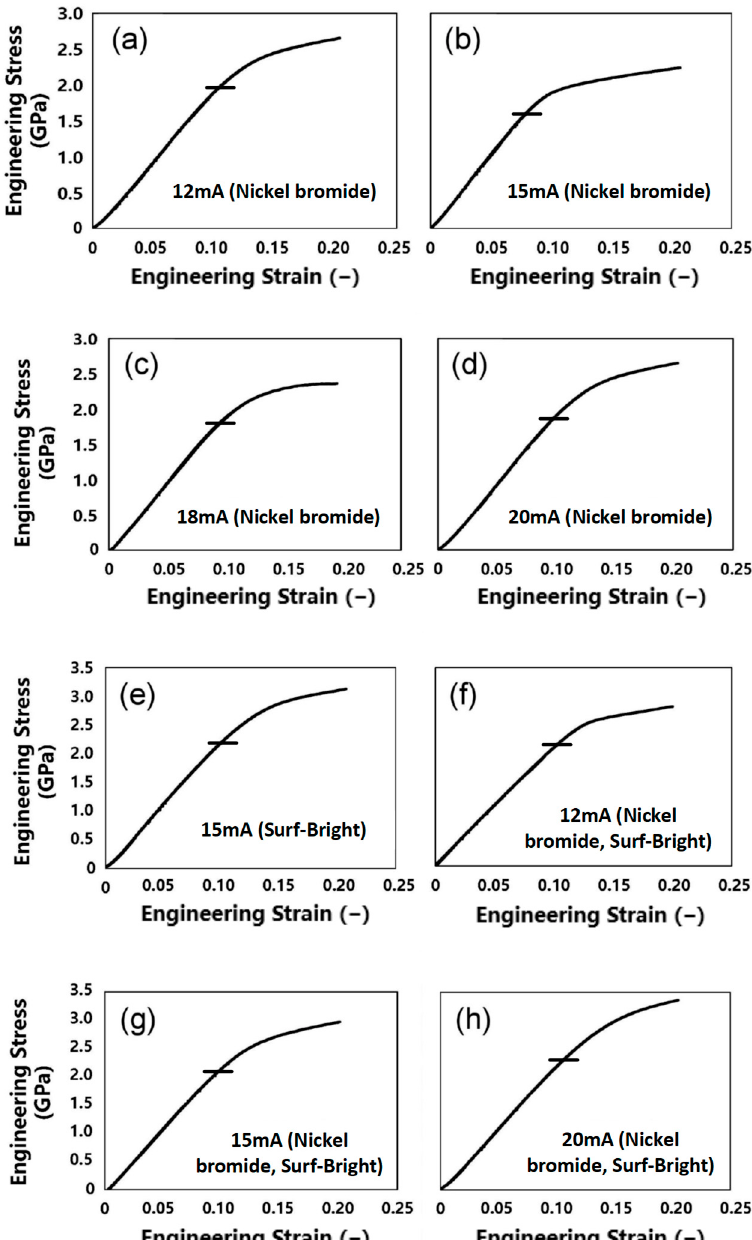
Figure 6. Engineering stress–strain curves generated from compression of the micro-pillars fabri- cated from the nickel–cobalt alloys electrodeposited with the bath containing ( a – d ) nickel bromide, ( e ) the Surf-Bright, or ( f – h ) both nickel bromide and the Surf-Bright, and at a current density of ( a , f ) 12 mA/cm 2 , ( b , e , g ) 15 mA/cm 2 , ( c ) 18 mA/cm 2 and ( d , h ) 20 mA/cm 2 . Relationships between the average grain size, micro-hardness and yield strength are shown in Figure 7. Generally, for both of the micro-hardness and yield strength, strengthening was observed following a refinement of the average grain size as illustrated by the dashed trendlines. This trend followed the Hall-Petch relationship well [29,30], and confirmed that the mechanical strength was mostly dependent on the grain boundary strengthening mechanism. Alloys with smaller grain size have fewer dislocations pile up and less stress at grain boundaries, which contributes to a higher mechanical strength. The highest yield strength at 2.37 GPa was obtained from the micro-pillar having the average grain size at 13.6 nm and 58.48 at.% of cobalt, and the highest micro-hardness at 457.4